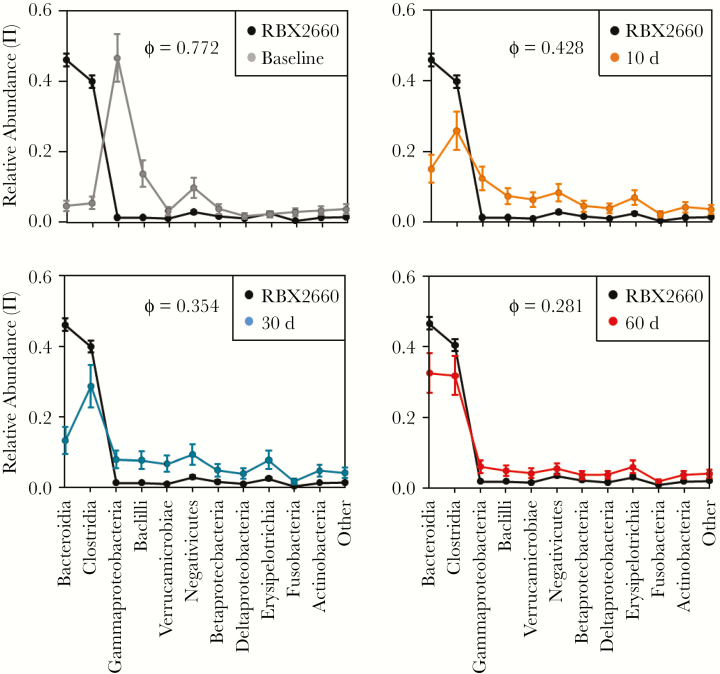
Effect size of each time point group compared with RBX2660. Mean relative abundance vectors (π) at the taxonomic class level are shown with upper and lower confidence intervals as determined by fitting to a Dirichlet-multinomial distribution. Effect size is expressed as a modified Cramer criterion, ϕ, for each pairwise comparison.